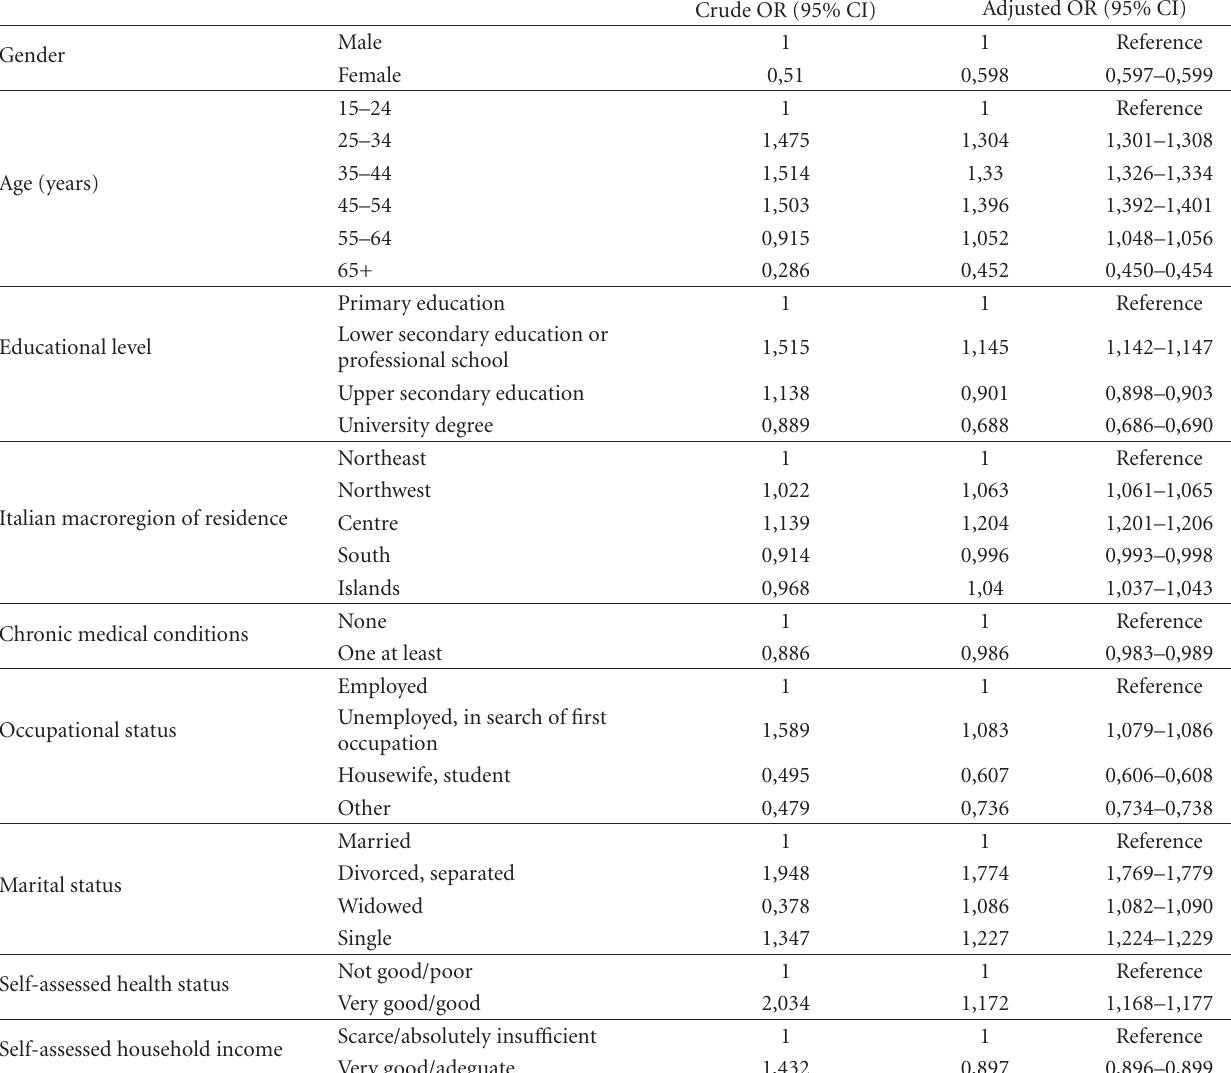
Table 2: Sociodemographic predictors of Current smoking —Multiple logistic regression model, year